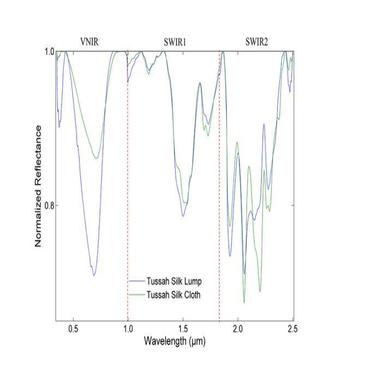
Spectral comparison between textile samples with different physical properties. (the 1st column: reflectance spectra; the 2nd column: CR spectra).